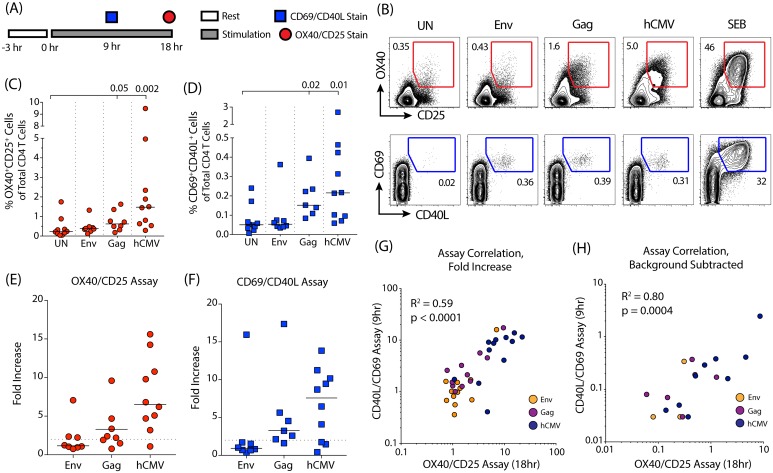
Comparing the OX40/CD25 and CD40L/CD69 AIM assays at their optimal time points.(A) A timeline of the assays’ setup and stimulation periods. (B) Example plots of OX40+CD25+ (red) and CD40L+CD69+ (blue) expression from human CD4 T cells when PBMC samples were unstimulated (UN), stimulated with peptides from HIV-Env, HIV-Gag, or hCMV, or stimulated with SEB as a positive control. Stimulation period was 9 hrs for the CD40L/CD69 assay and 18 hrs for the OX40/CD25 assay. Flow cytometry was gated as per S1 Fig (C,D) Quantitation of signal response to each antigen after 9 hrs or 18 hrs of stimulation for the CD40L/CD69 and OX40/CD25 assays, respectively. n = 8 for Env and Gag groups, n = 10 for NS and hCMV groups. P values shown comparing signal in the Gag and hCMV stimulations to the unstimulated (UN) condition for both assays (Wilcoxon test). (E,F) Quantitation of response measured by fold-increase (antigen-stimulation signal divided by the signal in the unstimulated control) for each antigen after 9 or 18 hrs of stimulation for the CD40L/CD69 and OX40/CD25 assays, respectively. Dotted line is shown at a fold-increase of 2, indicating positive signal threshold. (G,H) Correlation between the signals detected by the two assays after computing the fold increase and background subtracted values. The different antigen stimulations are shown in orange (Env), purple (Gag), or dark blue (hCMV). Rs = Spearman's Rank correlation coefficient with associated p values. For (E-H) n = 8 for Env and Gag groups, n = 10 for hCMV.